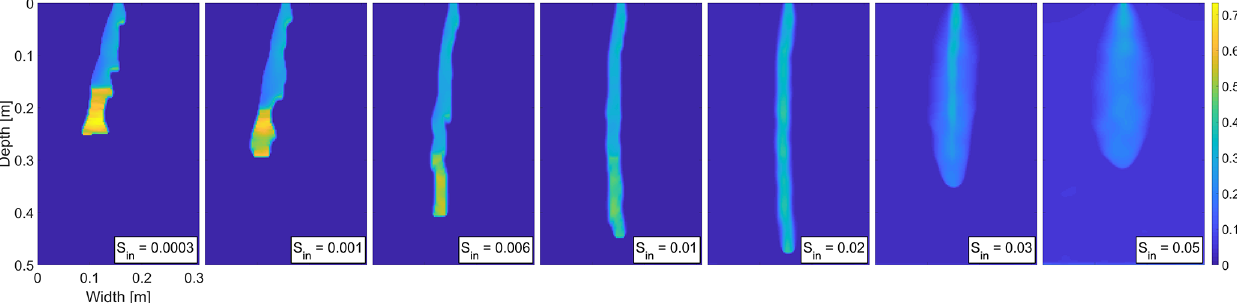
Figure 4. Snapshot of the saturation field at 25min for seven different values of the initial saturation. Saturation values are color coded according to the color bar on the right. Initial saturation of the medium increases from left to right.